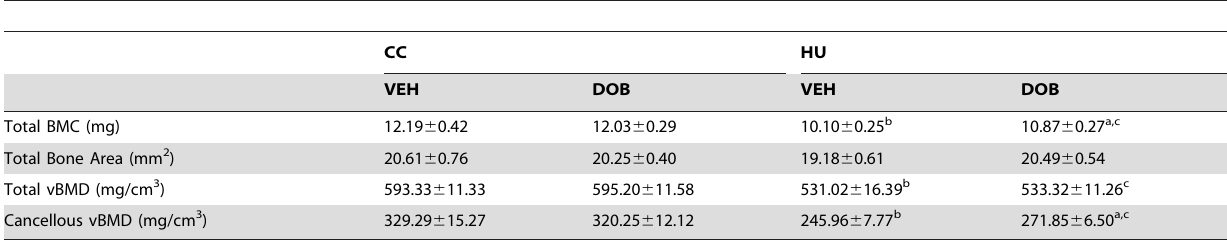
Table 2. Effects of dobutamine (DOB) or vehicle (VEH) administration during hindlimb unloading (HU) or ambulatory cage activity (CC) on metaphyseal bone mass and geometry at the distal femur as measured by ex vivo pQCT scans.